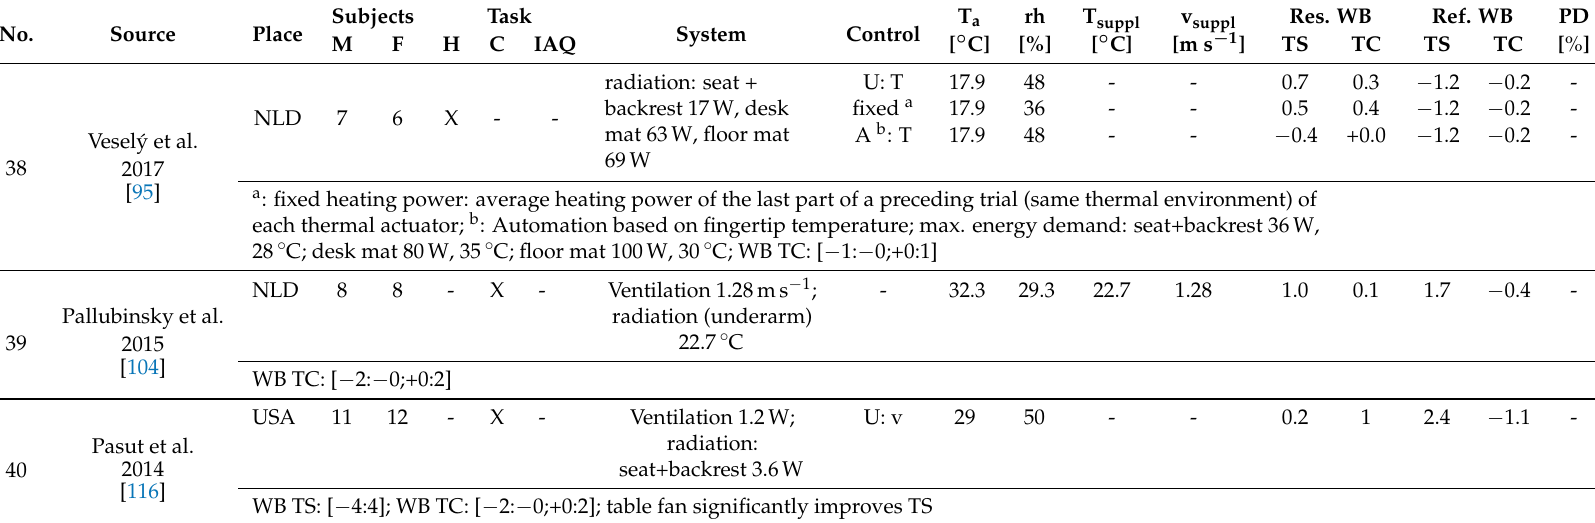
Table A5. Combination of personal thermal actuators (ventilation, radiation) for personal climatization